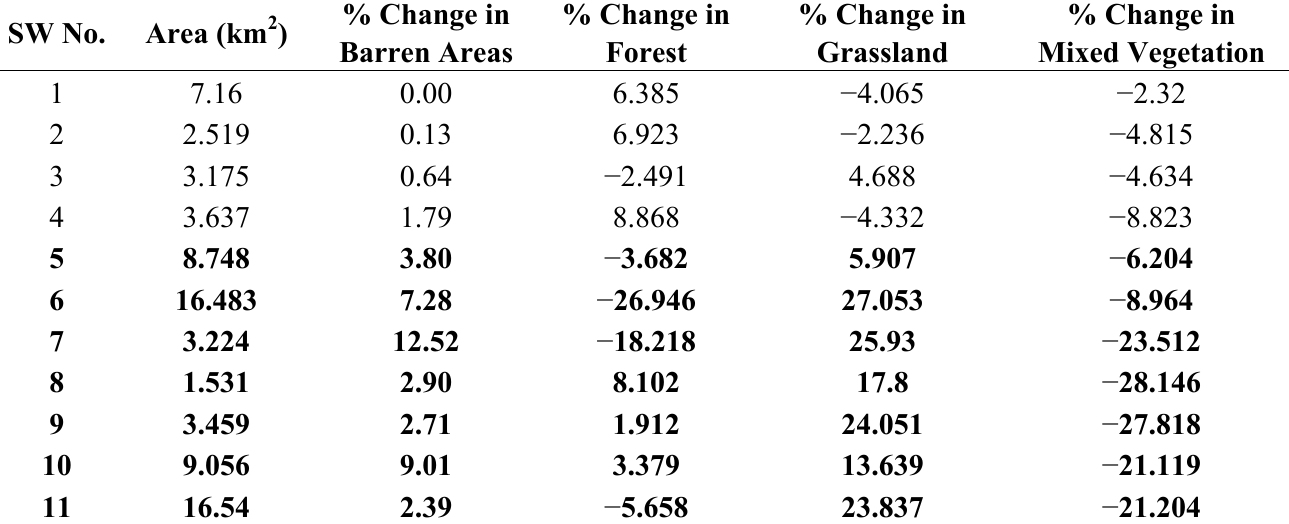
Table 6. Major land-cover change from 1976 to 2001 in sub-watersheds (SW). Percentage of change is computed with respect to the area of the sub-watershed. Negative values indicate reduction in percentage area from the 1976 condition. Highlighted are those SW where significant land-cover change has taken